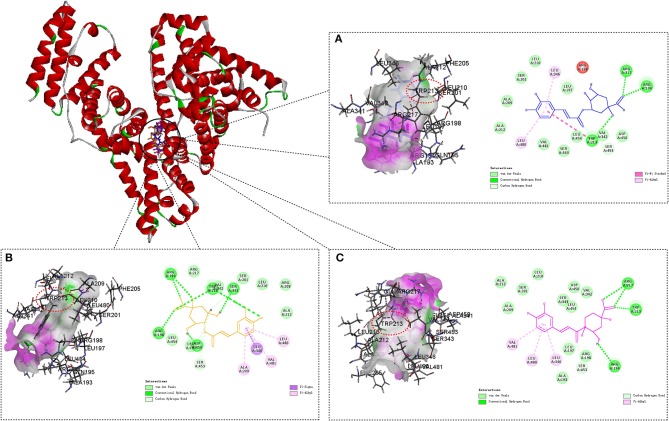
Molecule docking results for the interaction of 3-CQA (A), 4-CQA (B), and 5-CQA (C) with BSA. Compound docked in the binding pocket of BSA are placed at the left of the dotted box, and two-dimensional schematic representation of the interaction are shown at the right of the dotted box. Hydrogen bond depicts in green dashed line.